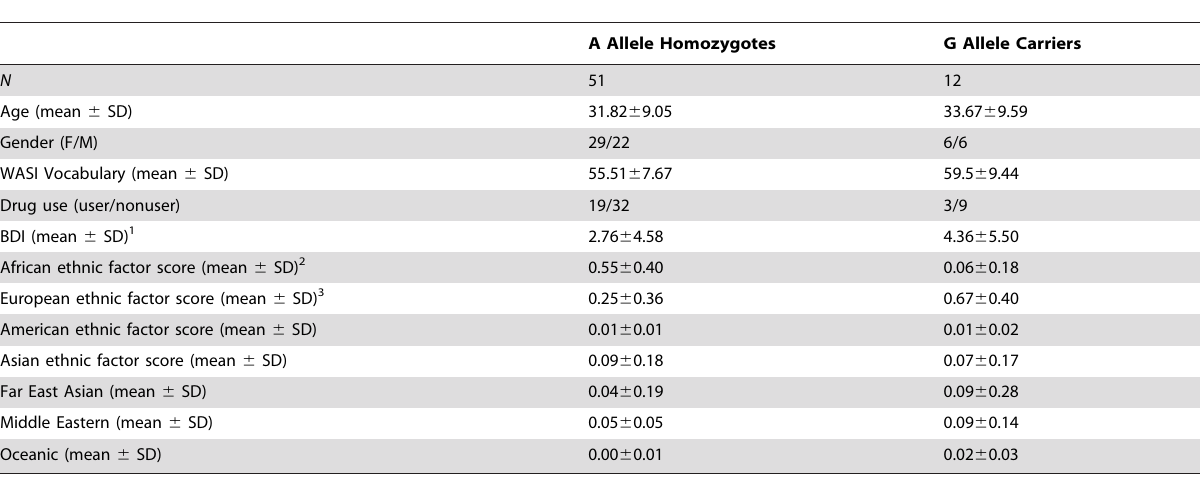
Table 1. Comparison of demographic variables between genotype